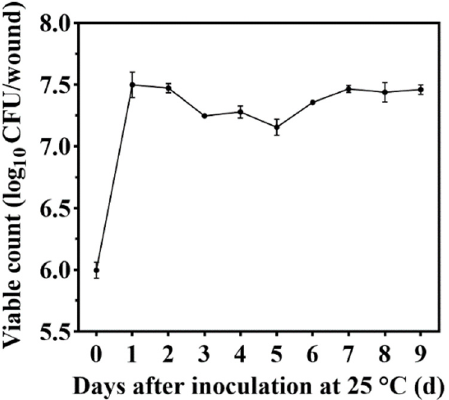
Figure 2. Colonization status of M. caribbica on jujube wounds. Vertical bars denote the standard error of the mean.